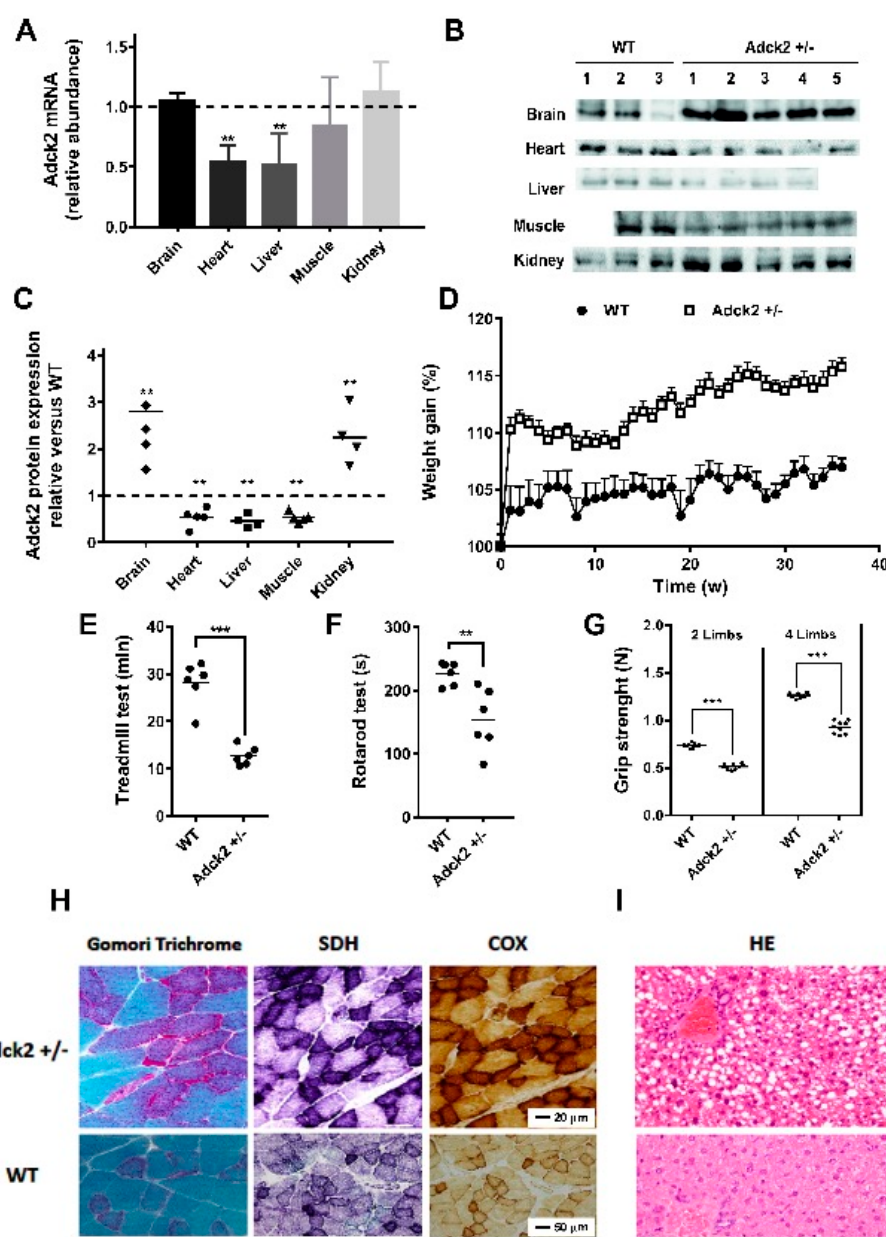
Figure 2. Characteristics of the Adck2 +/ − mouse model. ( A ) Relative abundance of Adck2 mRNA levels in di ff erent tissues of Adck2 +/ − mice after normalization to WT controls, depicted as a dotted line. Bars represent mean + SD; ** p < 0.01 ( n = 5 per group). ( B ) Western blot of ADCK2 protein in di ff erent mouse tissues. ( C ) Densitometry of ADCK2 protein levels from panel (B) ( n = 4–5). ( D ) Weight gain trajectories of WT and Adck2 +/ − male mice on standard diet ( n = 15). ( E ) Physical activity as determined by the running time on a treadmill until exhaustion. ( F ) The latency period before falling o ff an accelerating rotarod. ( G ) Grip strength capacity. ** p < 0.01 vs. WT; *** p < 0.005 vs. WT; n = 6. Data were analyzed by one-way ANOVA (D) and Student’s t test (panels A, B and E–G). ( H ) Skeletal muscle of Adck2 +/ − mice stained with Gomori trichrome, succinate dehydrogenase (SDH), and cytochrome c oxidase (COX) were compared to WT; 60 × magnification. ( I ) Light microscopy of mouse Adck2 +/ − liver showing extensive steatosis compared to WT liver after hematoxylin and eosin (HE) staining; 40 ×